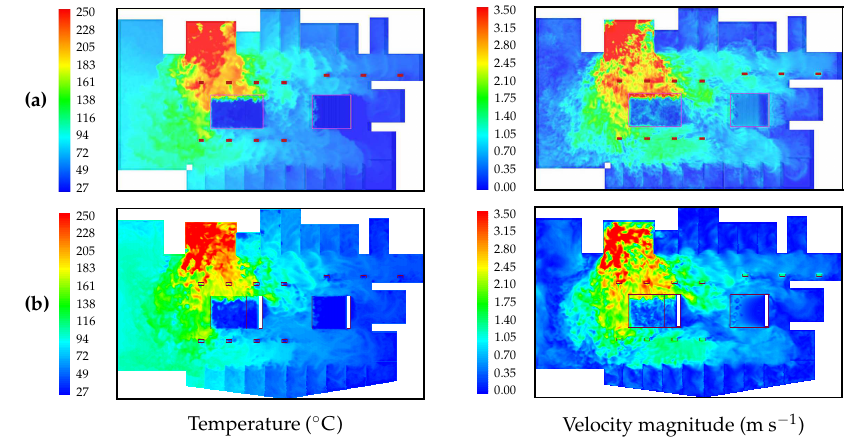
Figure 15. Temperature contours (left column) and velocity magnitude contours (right column) at t = 90 s, on the horizontal plane at z = 2.95 m, obtained as in Figure 13. (a) FDS; (b) FLUENT.